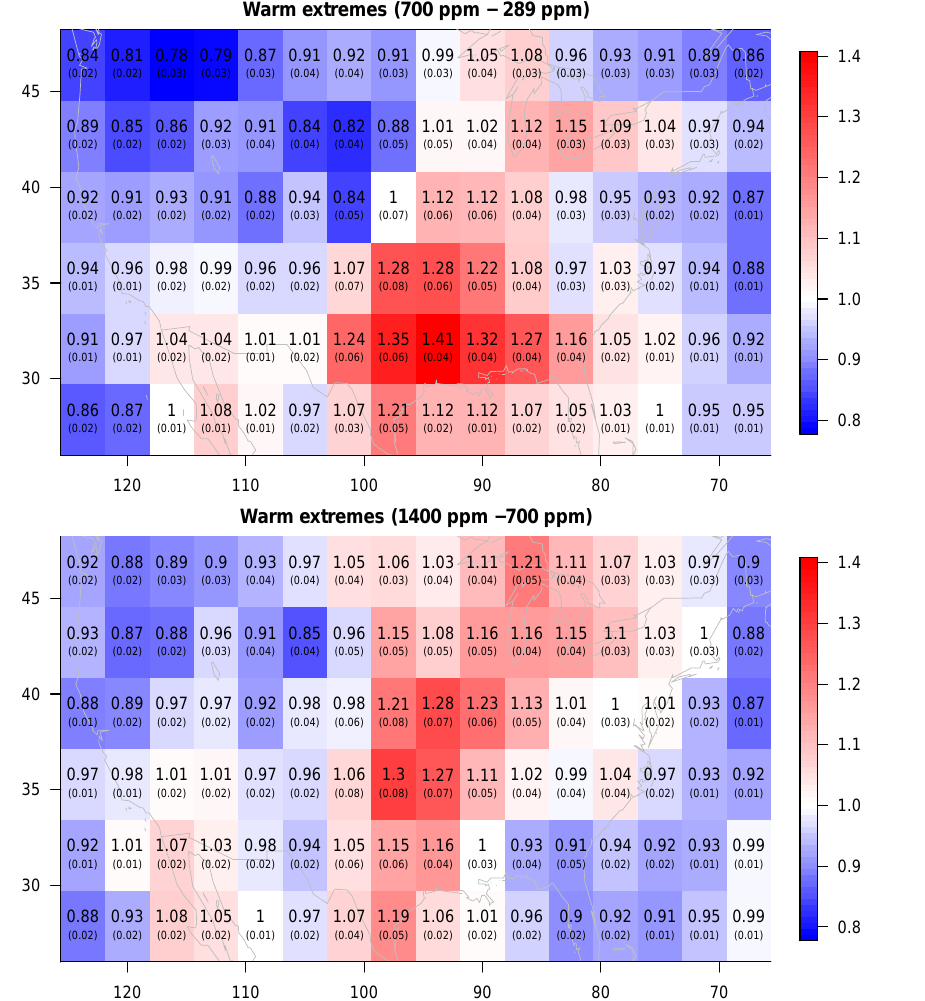
Figure E1. An investigation of the relationship of changes in the location parameter of warm extremes (i.e., (cid:49)µ ) with changes in summer means ( (cid:49)m ). Top: the ratio of changes in the location parameter of extremes to changes in means for the climate state from pre-industrial to 700ppm. Bottom: the ratio for climate states 700 and 1400ppm. Red (blue) grid cell location indicates that the shift of the GEV distribution is larger (smaller) than the shift of the overall distribution. Numbers on the top are the estimated ratios (i.e., (cid:49) ˆ µ/(cid:49)m ) and numbers in parentheses are the bootstrapped standard errors for (cid:49)µ . These ratios are generally near 1 in the contiguous United States.